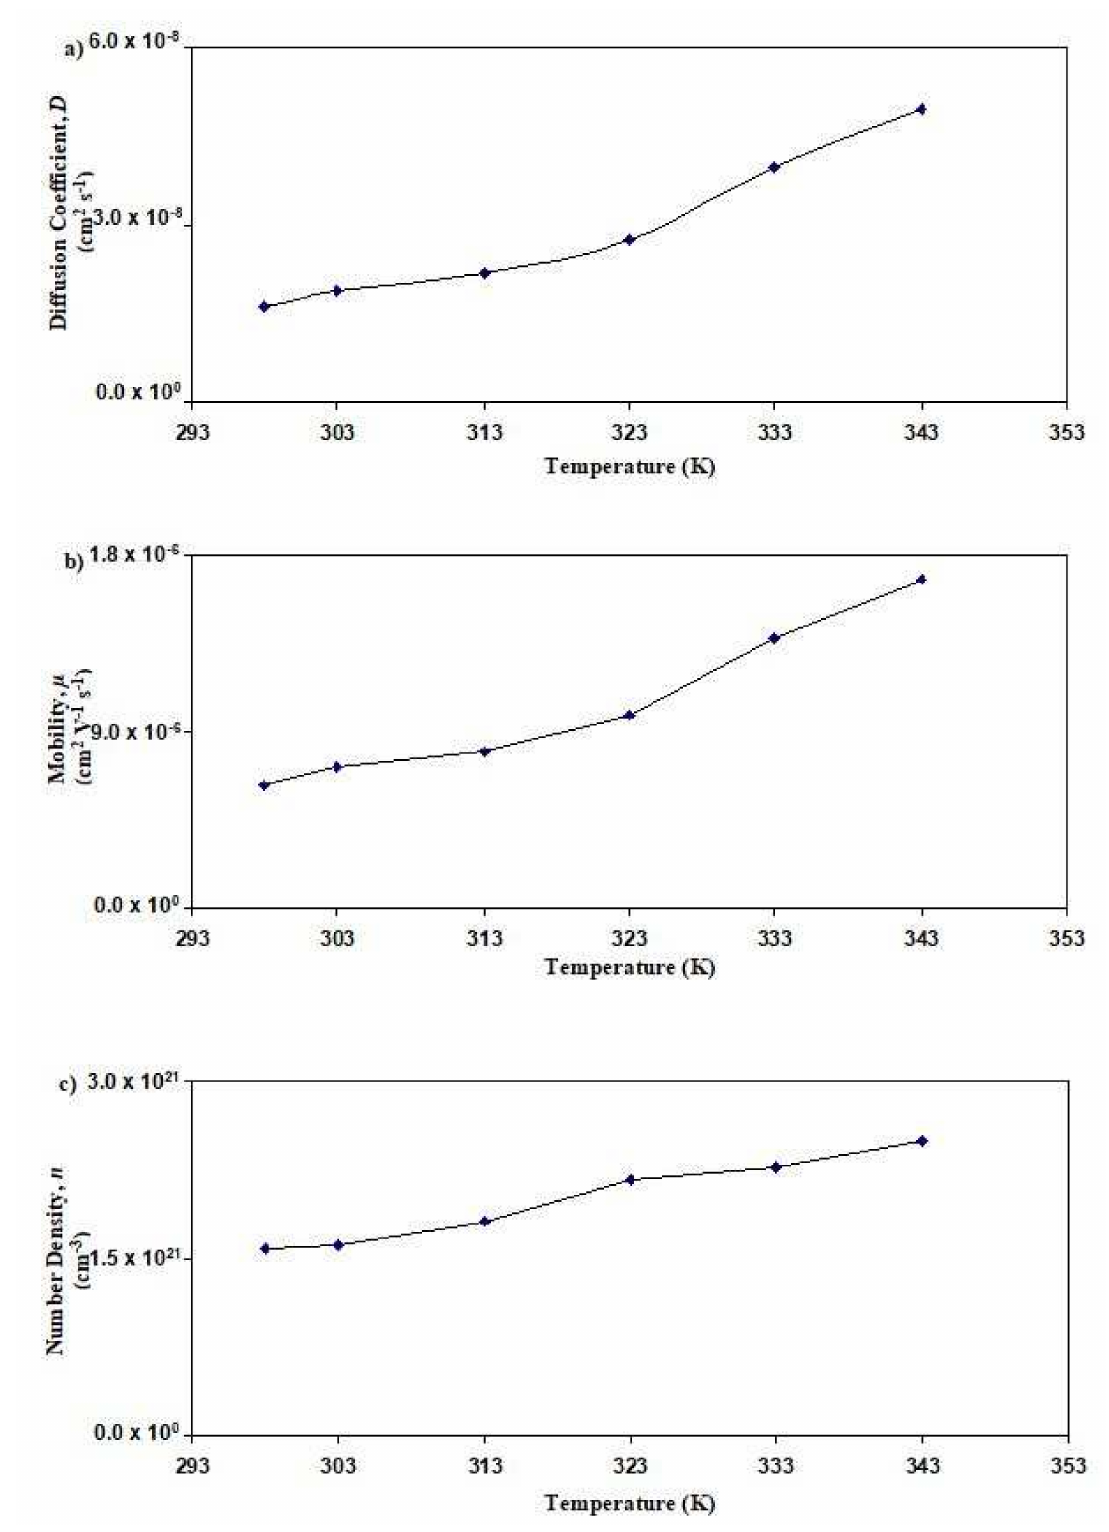
Figure 10. Graph of ( a ) D , ( b ) µ , and ( c ) n for the SL4 electrolytes at various